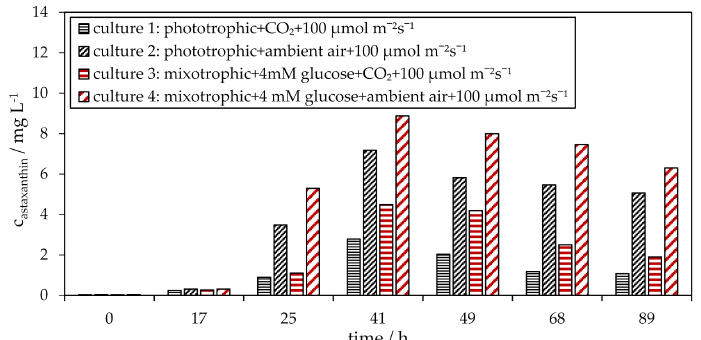
Figure 3. Astaxanthin concentration in the ethyl acetate extract of the phototrophic culture 1 (pho- totrophic + CO 2 + 100 µ mol m − 2 s − 1 ) and culture 2 (phototrophic + ambient air + 100 µ mol m − 2 s − 1 ), and the mixotrophic culture 3 (mixotrophic + 4 mM glucose + CO 2 + 100 µ mol m − 2 s − 1 ) and culture 4 (mixotrophic + 4 mM glucose + ambient air + 100 µ mol m − 2 s − 1 ) at different time points after the start of germination; data obtained by single